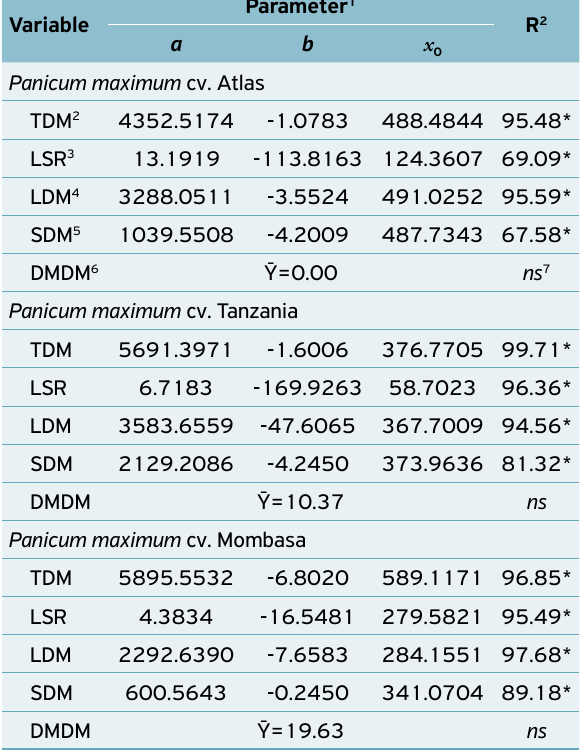
Panicum maximum cv. Atlas